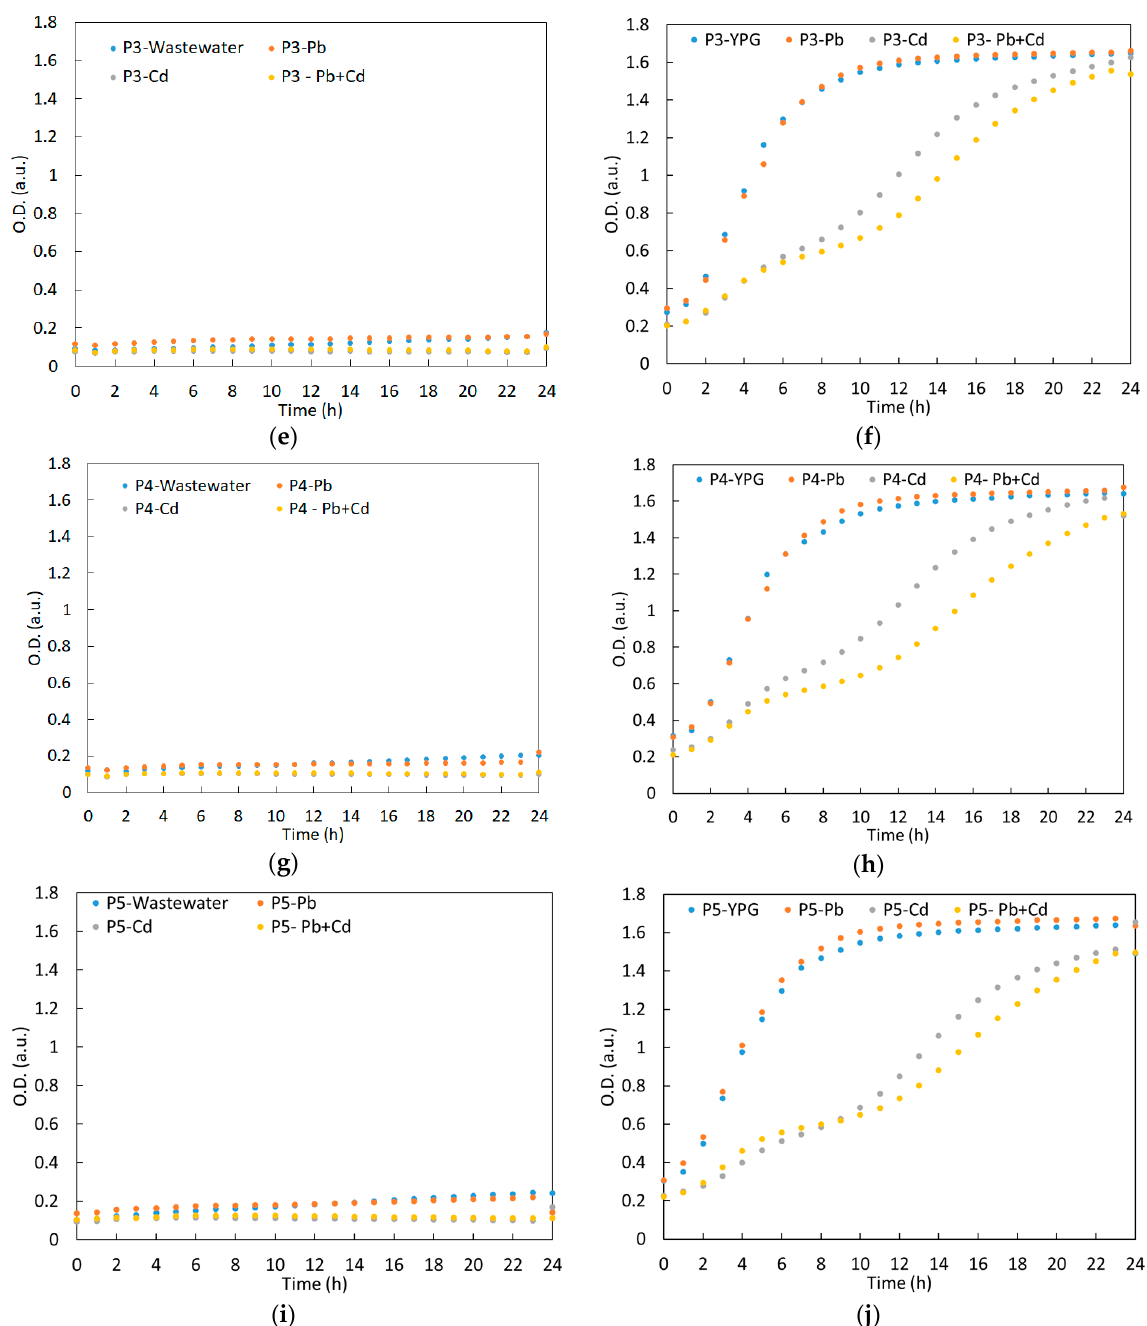
Figure 2. Growth curve of yeast strains in the presence of Pb 2+ , Cd 2+ and Pb 2+ + Cd 2+ in: synthetic wastewater: ( a ) K. marxianus CMGBP16 (P1); ( c ) S. cerevisiae S228C (P2); ( e ) S. cerevisiae CM6B70 (P3); ( g ) S. cerevisiae CMGB234 (P4); ( i ) P. anomala CMGB88 (P5) and in YPG medium: ( b ) K. marxianus CMGBP16 (P1); ( d ) S. cerevisiae S228C (P2); ( f ) S. cerevisiae CM6B70 (P3); ( h ) S. cerevisiae CMGB234 (P4); ( j ) P. anomala CMGB88 (P5).